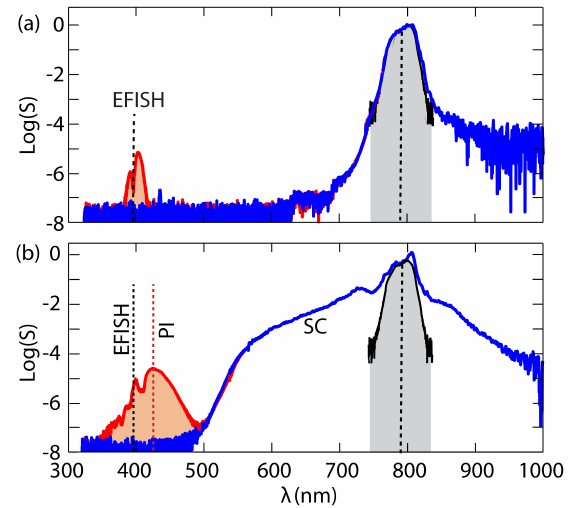
Figure 2. ( a ) Experimental measurement showing the electric field-induced second harmonic (EFISH) generation signal typically observed for low pump intensities (red, shaded curve, S stands for power spectrum). The blue curve shows the pump pulse spectrum after the propagation in the crystal without any injected THz seed. The black shaded curve shows a section of the input spectrum (a very limited spectral reshaping of the pump pulse is evident); ( b ) as in (a), but for a higher pump pulse intensity. The occurrence of an additional signal at ∼ 430 nm is clearly visible in the red shaded